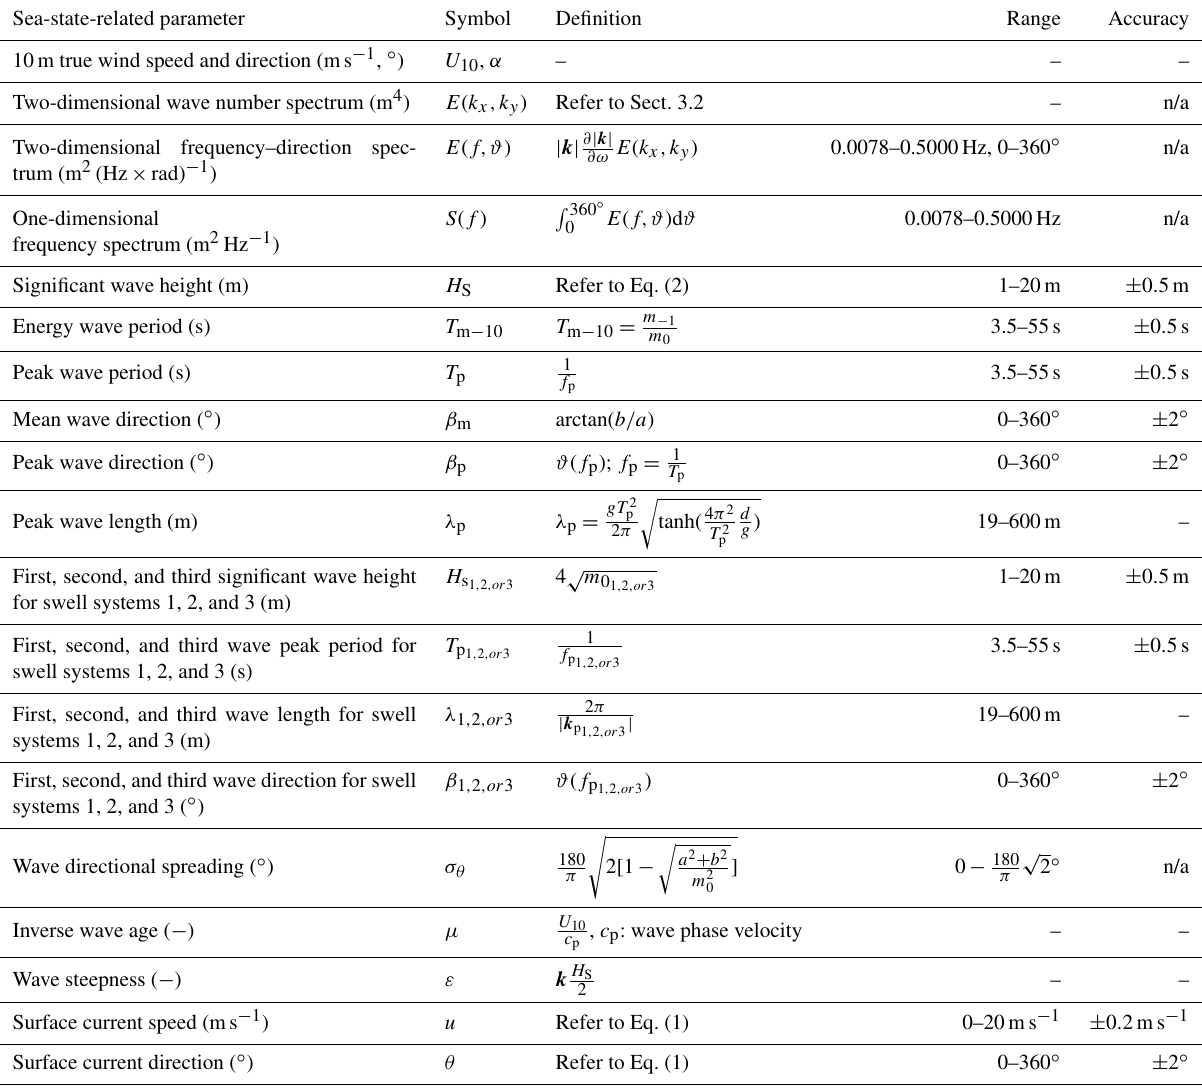
Table A1. WaMoS-II output and integrated sea-state-related parameters and their symbol, definition, range, and accuracy. “n/a” stands for “not